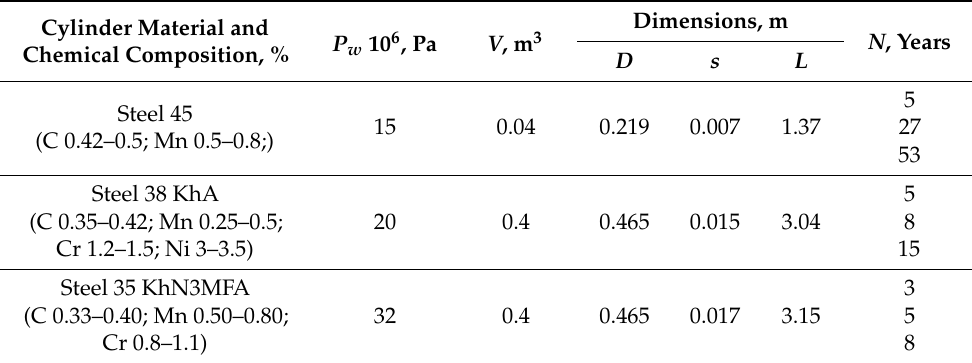
Table 2. Chemical composition of materials [31] and parameters of the investigated hydrogen cylinders [41]. Cylinder Material and